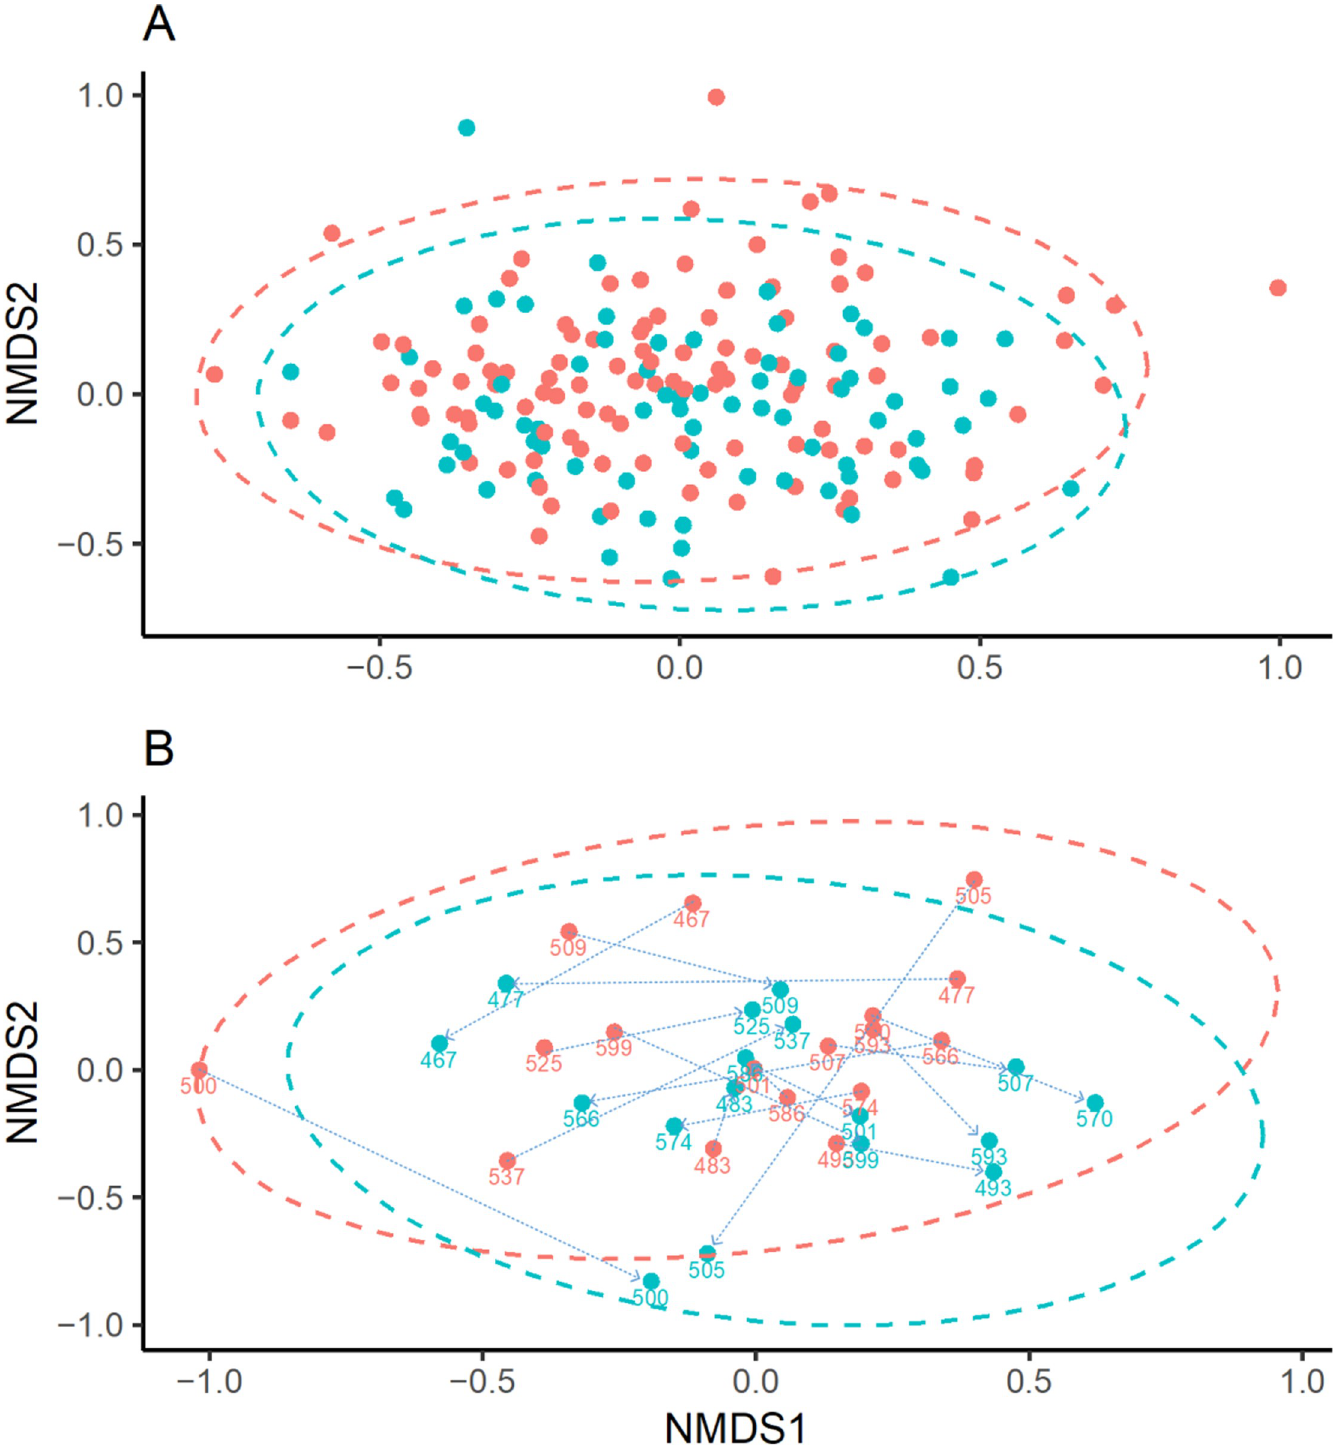
Fig 2. NMDS plots based on Bray-Curtis dissimilarity comparing. A) non-wheezing controls (blue) to acute wheezing children (red), R 2 = 0.016. B) Wheezing children (red) and paired follow-up samples (blue). Numbers indicate paired samples from individual patients and are linked by arrows. Ellipses were added assuming a multivariate normal